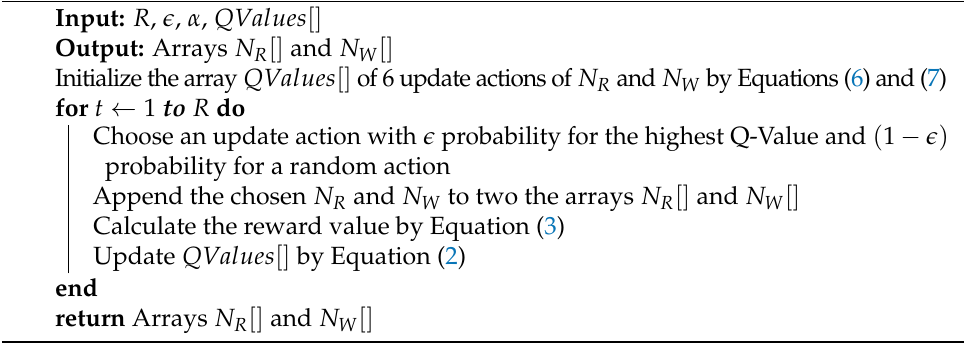
Algorithm 1: Reinforcement learning consistency algorithm for